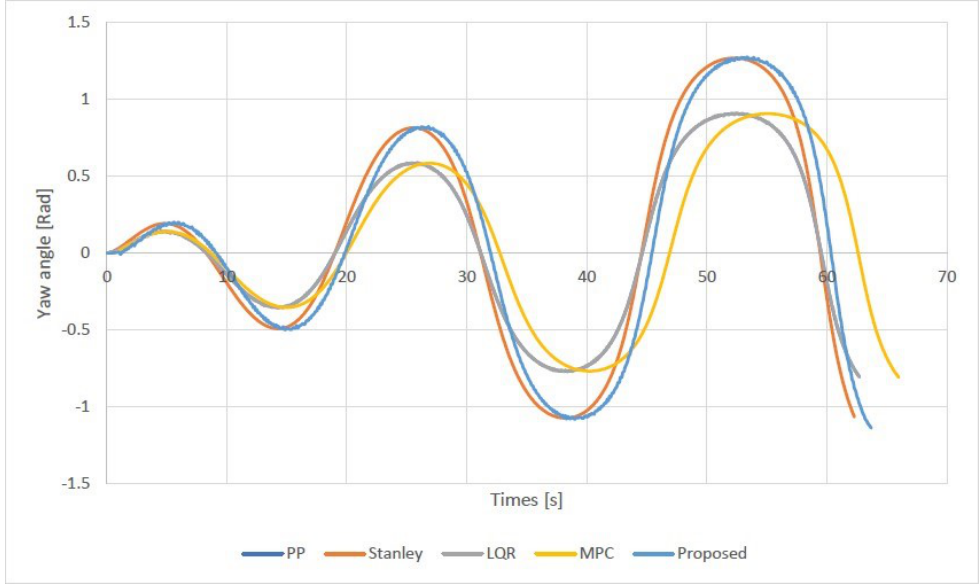
Figure 8. Yaw angle comparison for different trajectory tracking controllers in the simulated trajectory.